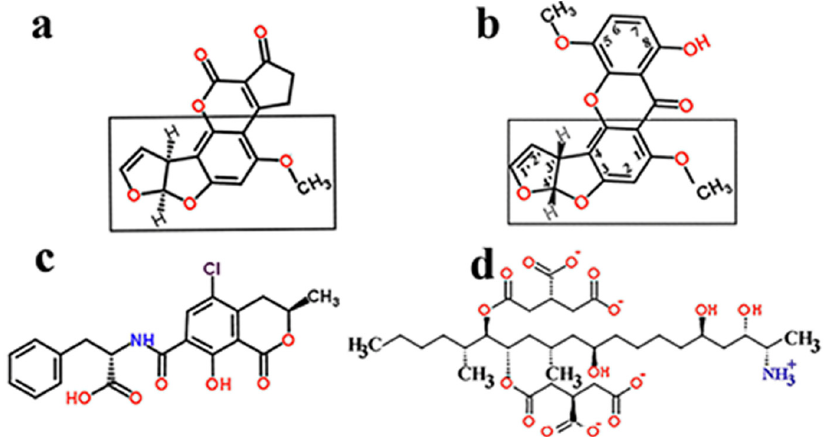
Figure 2. Structural similarities and IARC carcinogenic classification of major Fusarium mycotox-